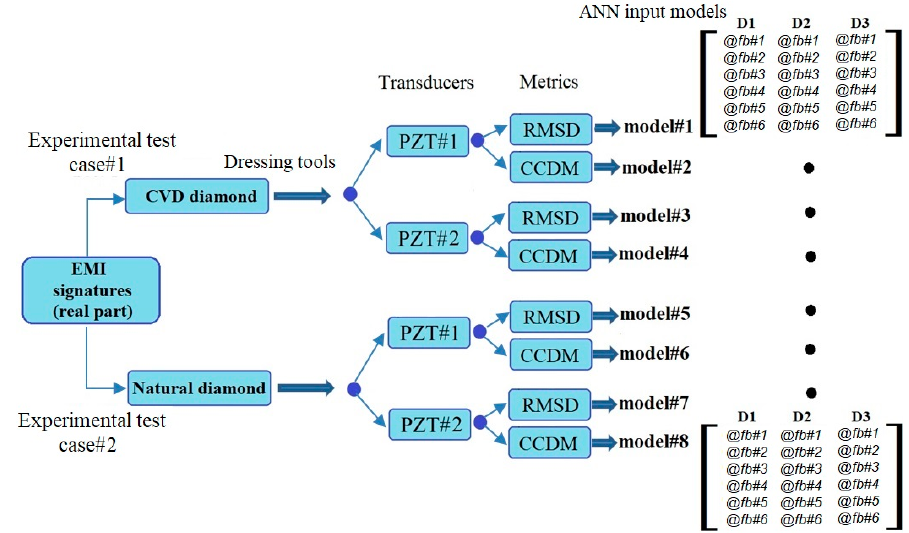
Figure 3. Artificial neural network (ANN) model construction.